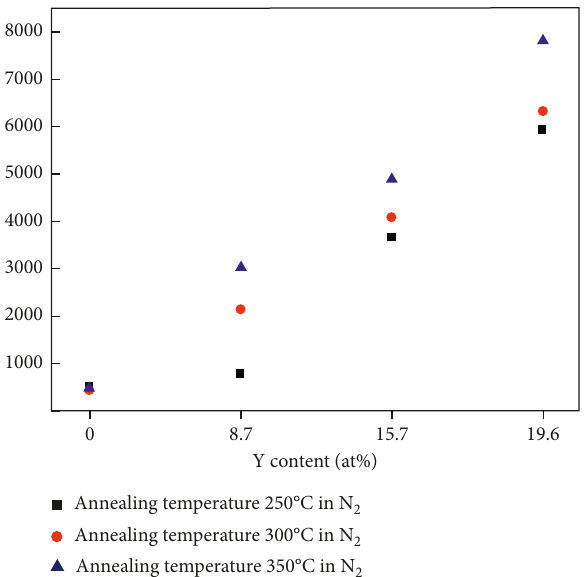
Figure 6: CuMn film room temperature resistivity with various yttrium contents annealed at different temperatures.